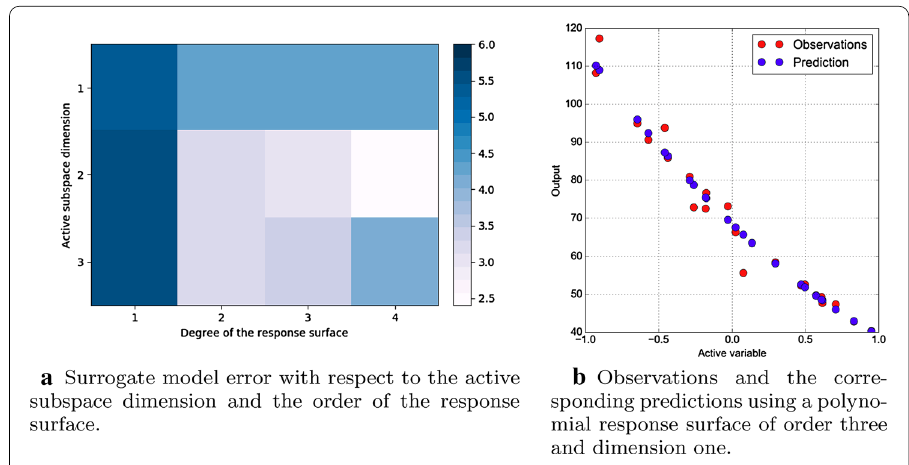
Fig. 12 Plot a shows the relative error on the test dataset with respect to the active subspace dimension and the order of the response surface; plot b shows the observations of the test dataset and the corresponding predictions using a polynomial response surface of order